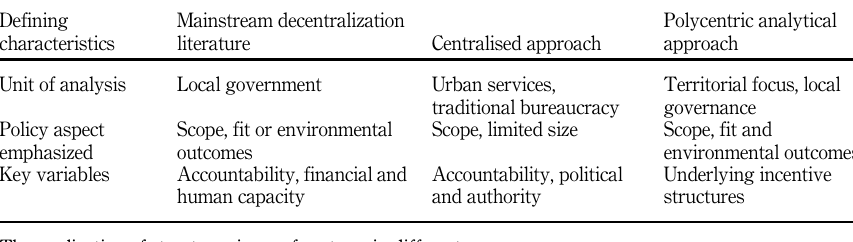
Table 1. Comparison of features of decentralization, centralization